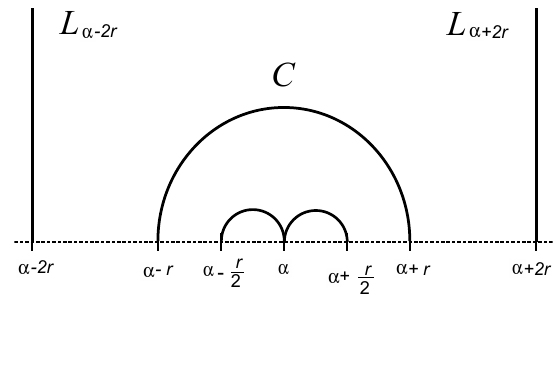
Figure 4: Inversion in C